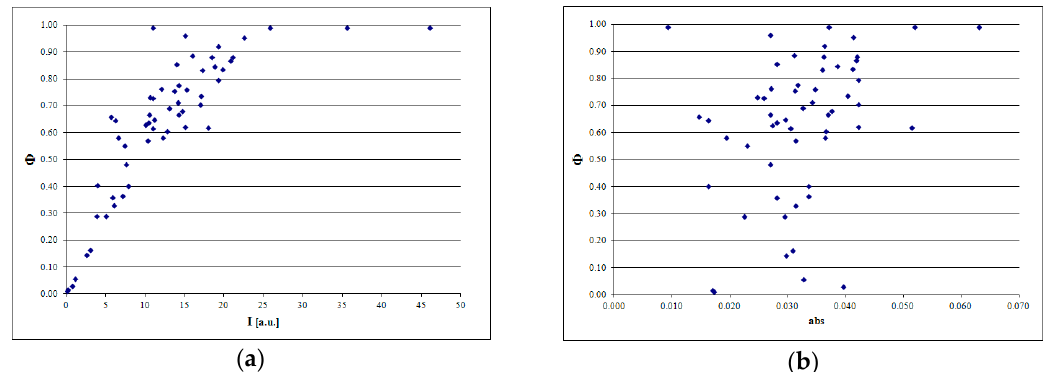
Figure 3. Quantum yield of studied compounds: ( a ) Quantum yield and intensity of fluorescence of studied compounds; ( b ) Quantum yield of fluorescence and absorbance at excitation wavelength ( λ ex max ) of studied compounds.